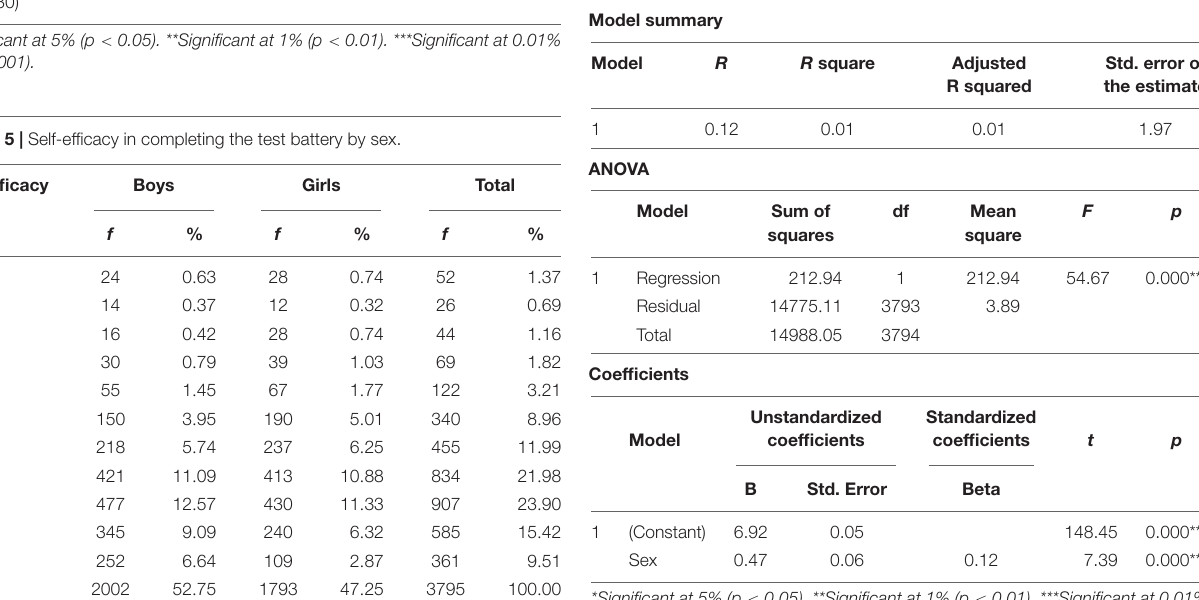
TABLE 6 | Regression analysis between sex and self-efficacy